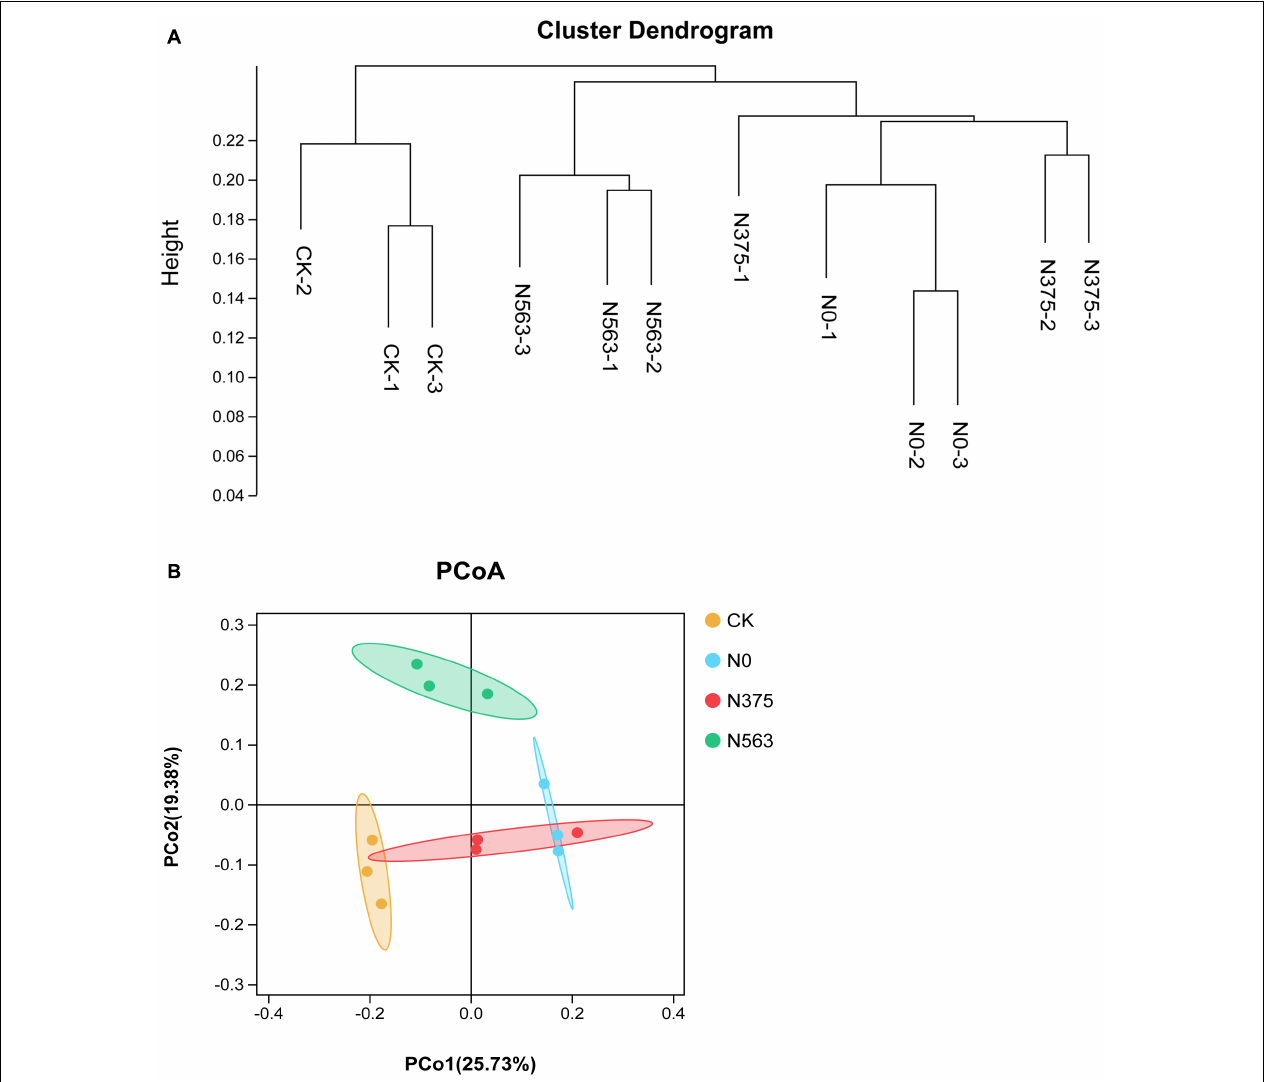
FIGURE 2 | The (A) unweighted pair group method with arithmetical averages (UPGMA) cluster analysis and (B) principal coordinate analysis of bacterial communities based on OTUs.